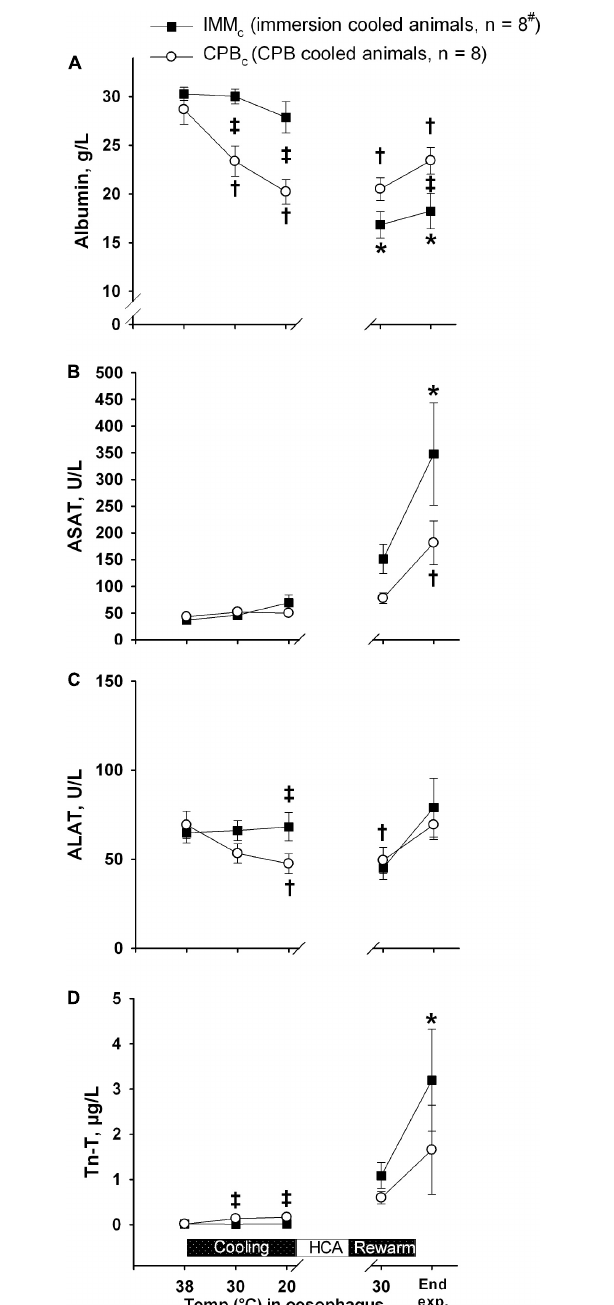
FIGURE 7 | Biochemical analyses. (A) : Albumin; (B) : ASAT; (C) : ALAT; (D) : Troponin-T (Tn-T). Data presented as mean and SEM. *Statistically significant difference from baseline within IMM c group, and † within CPB c group ( p < 0.05). ‡ Statistically significant difference between groups ( p < 0.05).